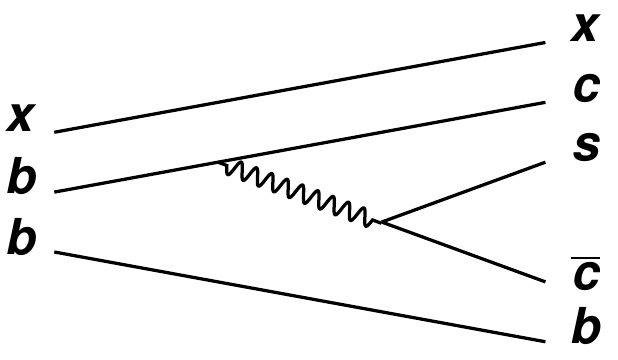
Figure 1 . Diagram for production of a B (cid:0)